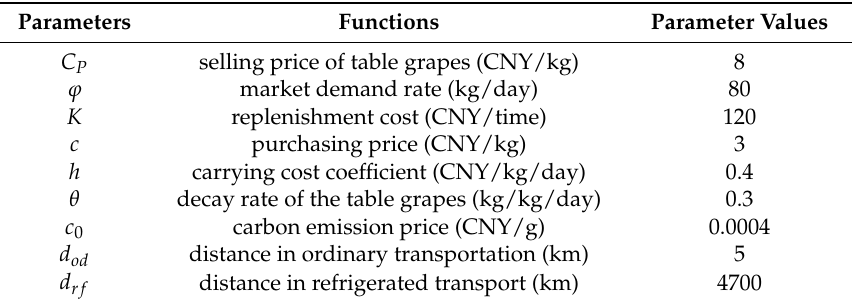
Table 4. The model parameters. CNY, China Yuan.